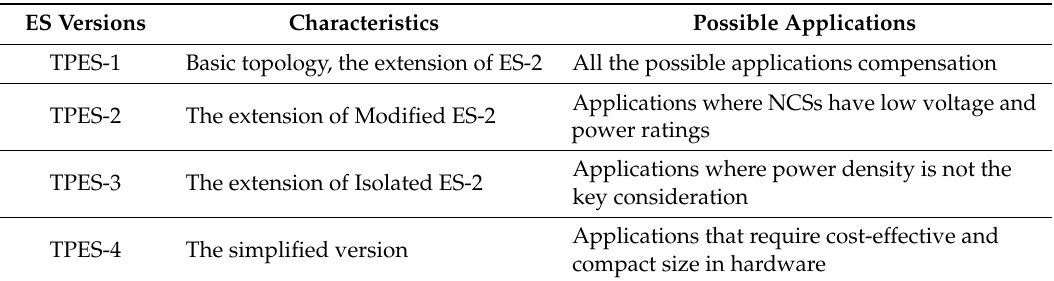
Table 2. Characteristics and possible applications of three-phase ESs.